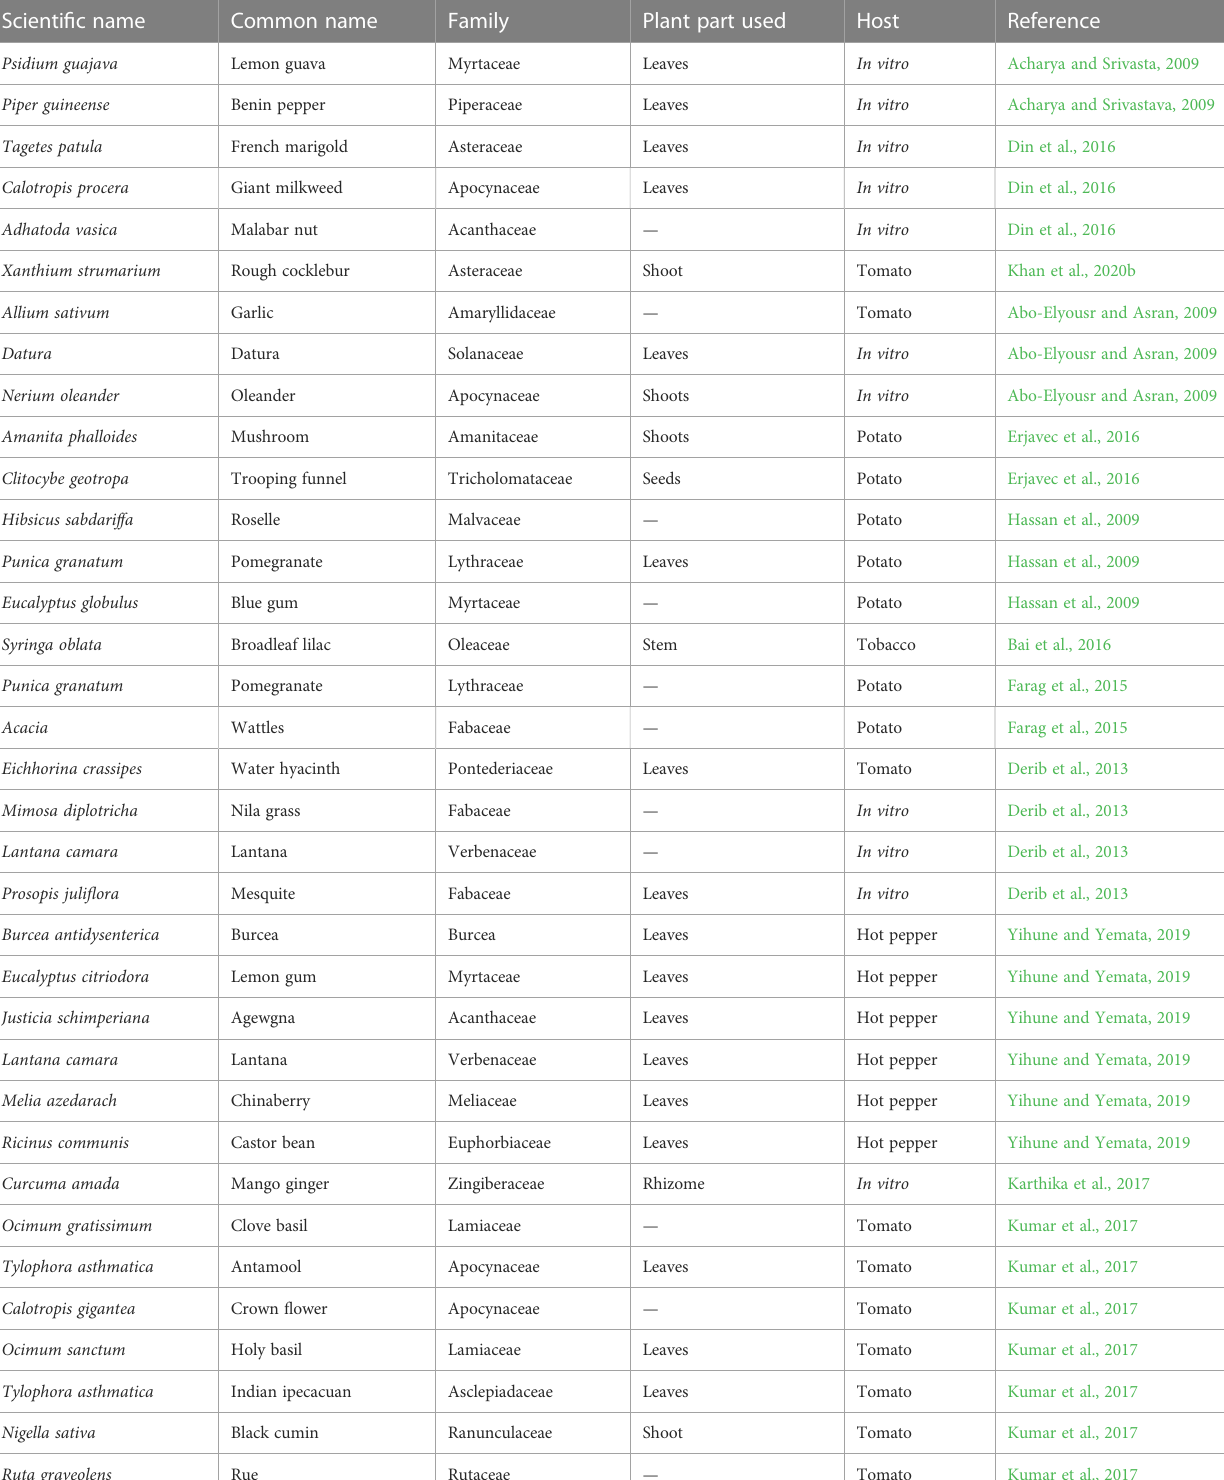
TABLE 2 Plants tested for their antibacterial potential against R. solanacearum and management of BW disease in different